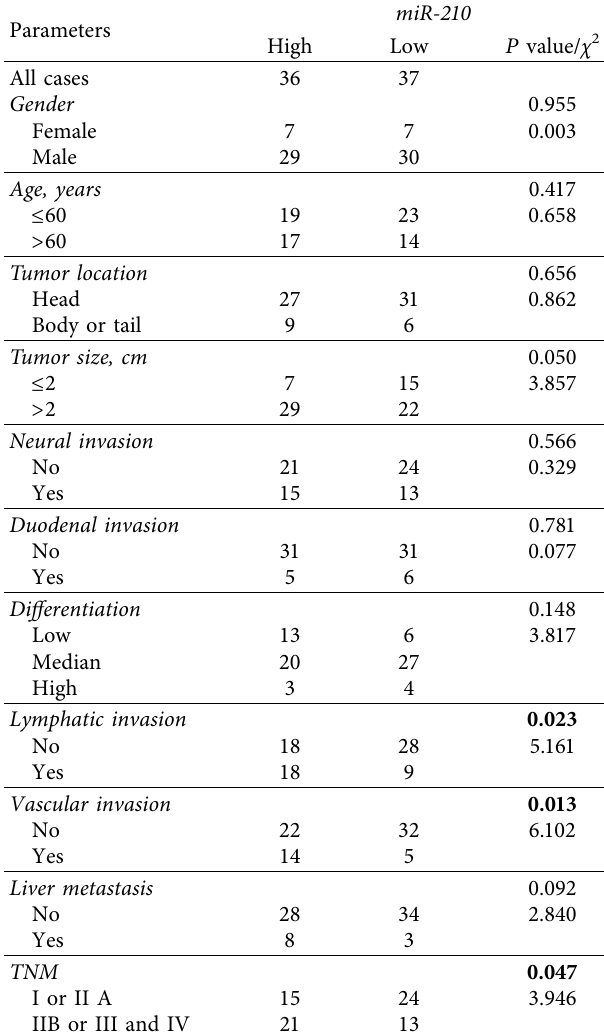
Table 1: Clinical characteristics and expressions of exosomal miR-222 in 73 pancreatic carcinoma